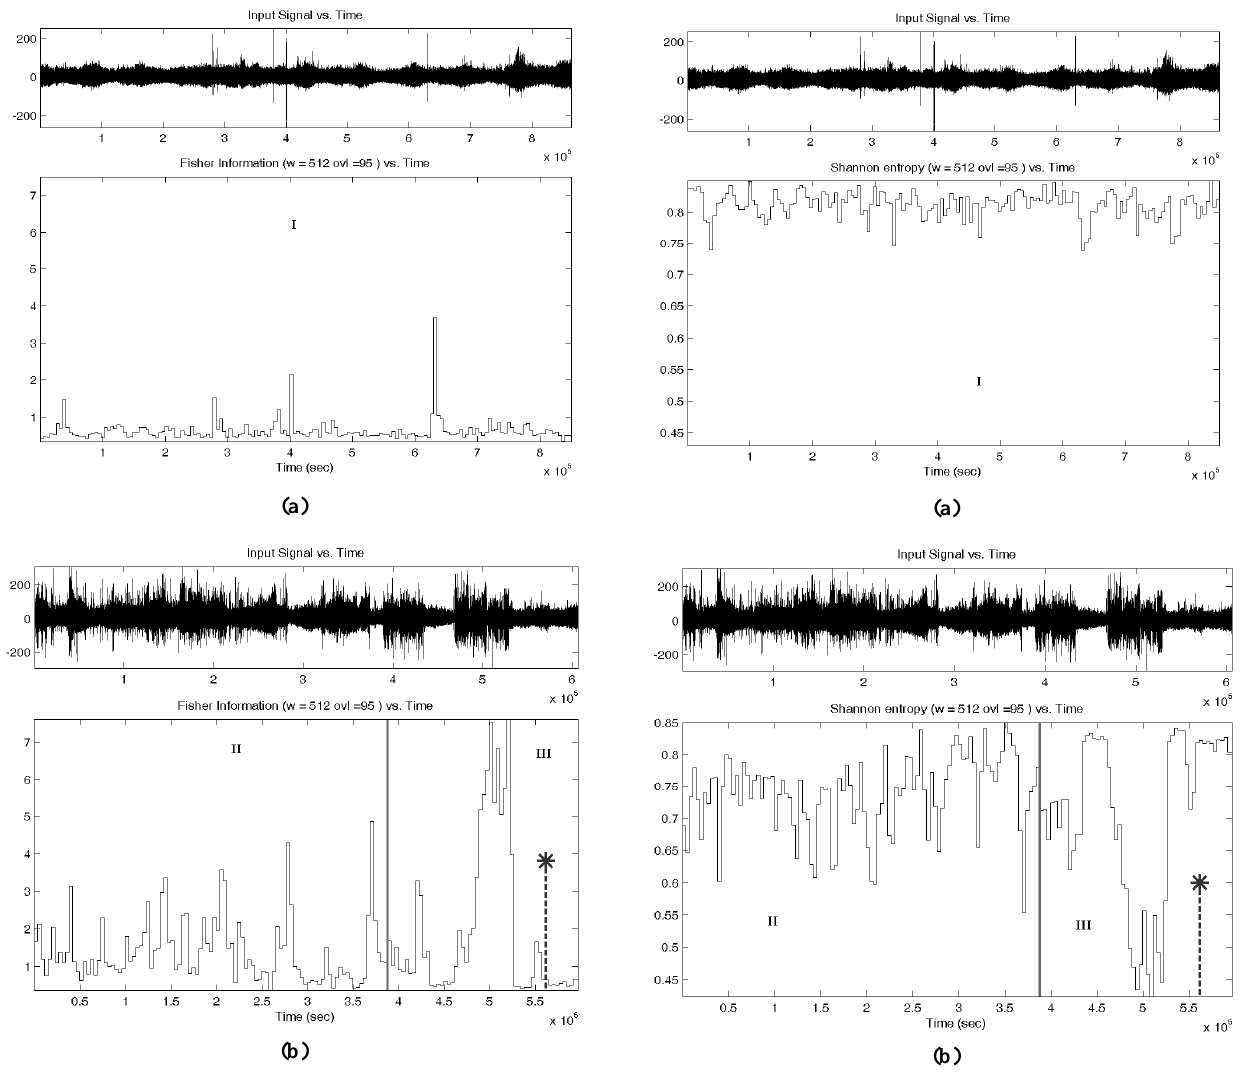
Fig. 4. Shannon entropy evolution with time (a) for epoch I, and (b) for the epochs II and III of the signal of Fig. 2. The analyzed signal is given on top of the resulted Shannon entropy temporal evolution, time aligned for direct reference. We observe a gradual increase of the organization of the underlying process as the EQ is